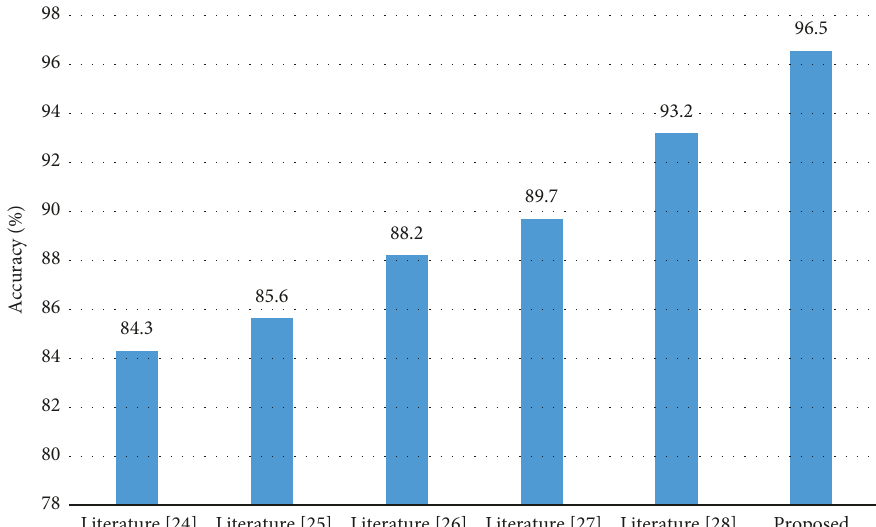
Figure 9: Experimental results of online classroom behaviour recognition data